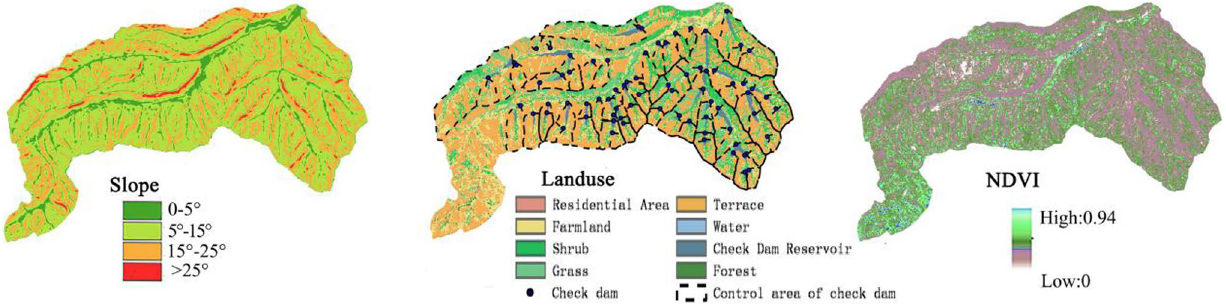
Fig. 7 Maps of the slope, land use and NDVI. a Slope map is to generate the four classed; b land-use map; c NDVI